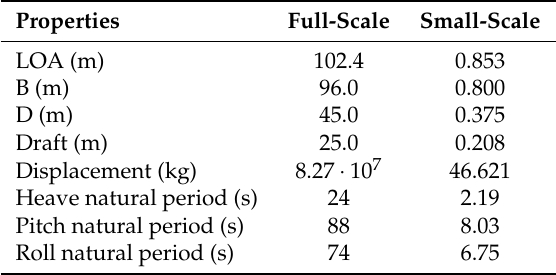
Table 1. Geometric properties of the semisubmersible